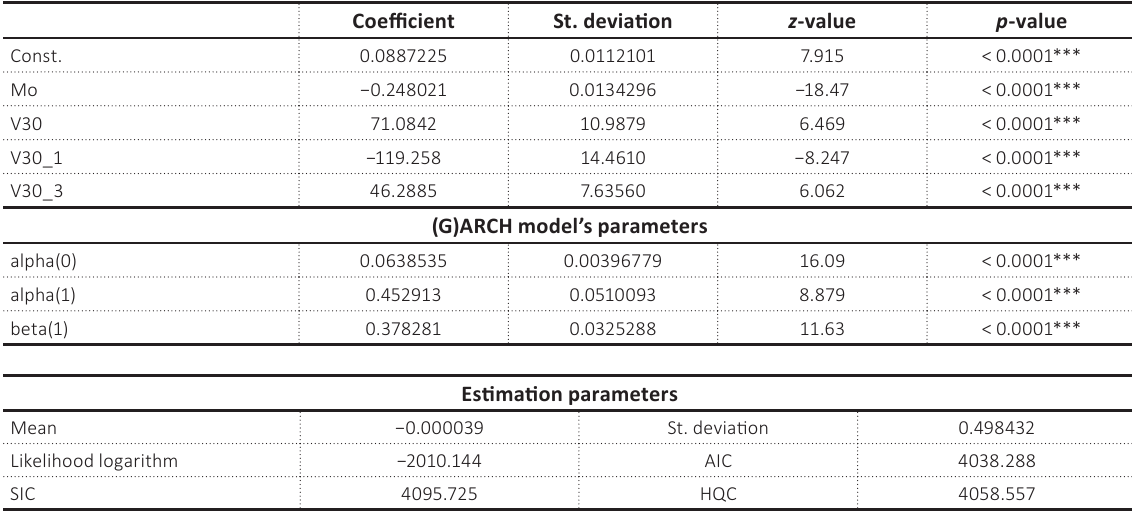
Table 4. GARCH(1,1) estimation for FTSE 100 index